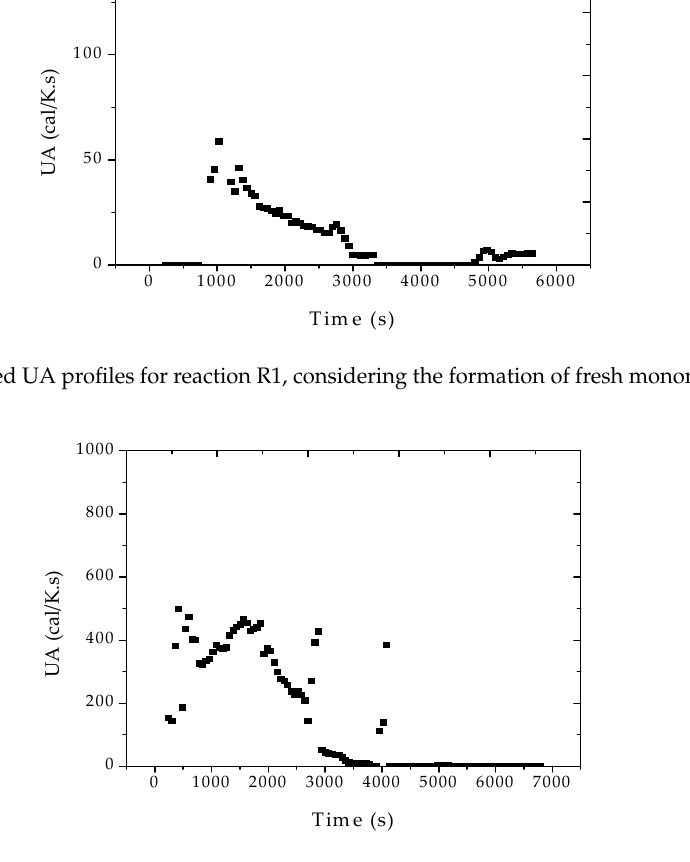
Figure 7. Reconciled UA profiles for reaction R3, considering the formation of fresh monomer droplets.